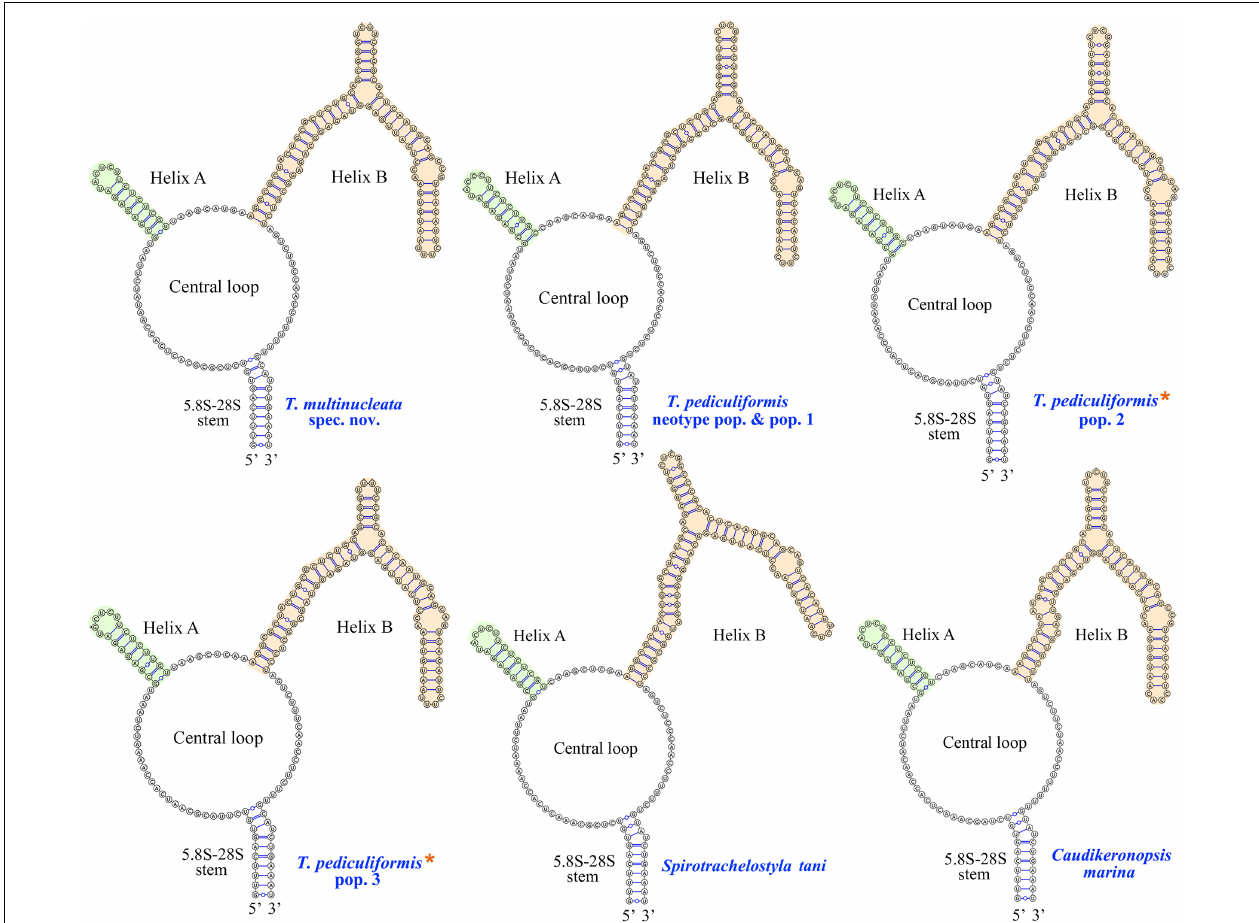
FIGURE 10 | Putative secondary structures of the ITS2 molecule of five trachelostylids and Caudikeronopsis marina . Trachelostyla pediculiformis pop. 2 and 3 marked by red asterisks were two misidentified materials in Huang et al.